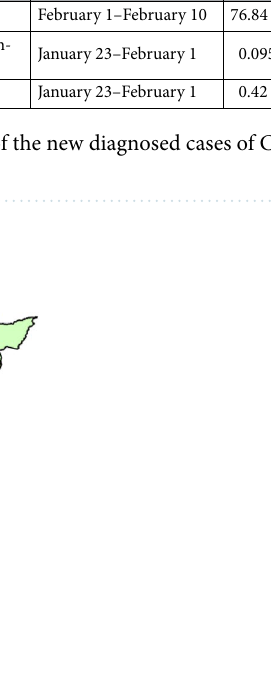
Figure 4. The spatio-temporal aggregation of the new diagnosed cases of COVID-19. Maps constructed using ArcGIS 10.2 (https:// s2. loli. net/ 2022/ 01/ 11/ fA85D xBvaU EGbmK.